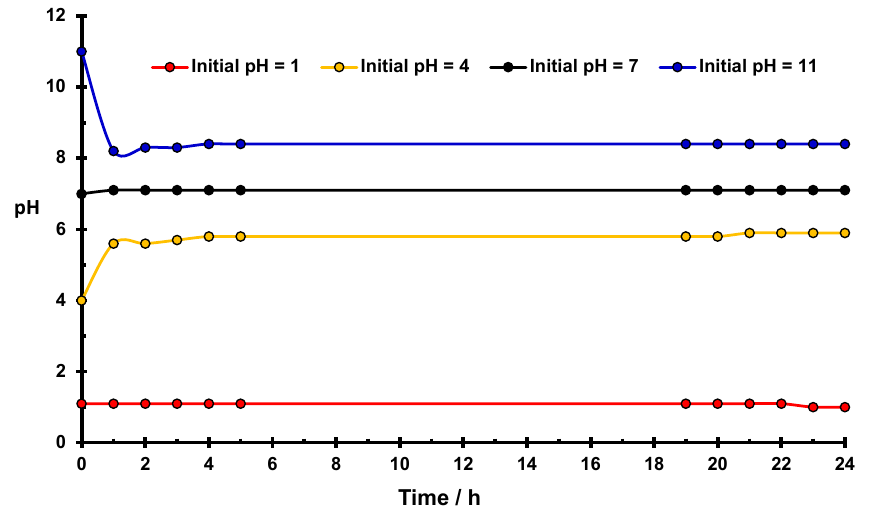
Figure 5. Changes of pH for the native starch suspension in water solution of K 2 Cr 2 O 7 (concentration of Cr(VI) = 1 g/L) as a function of time. Conditions: 5 g of starch in 22.5 cm 3 of a solution, room temperature.